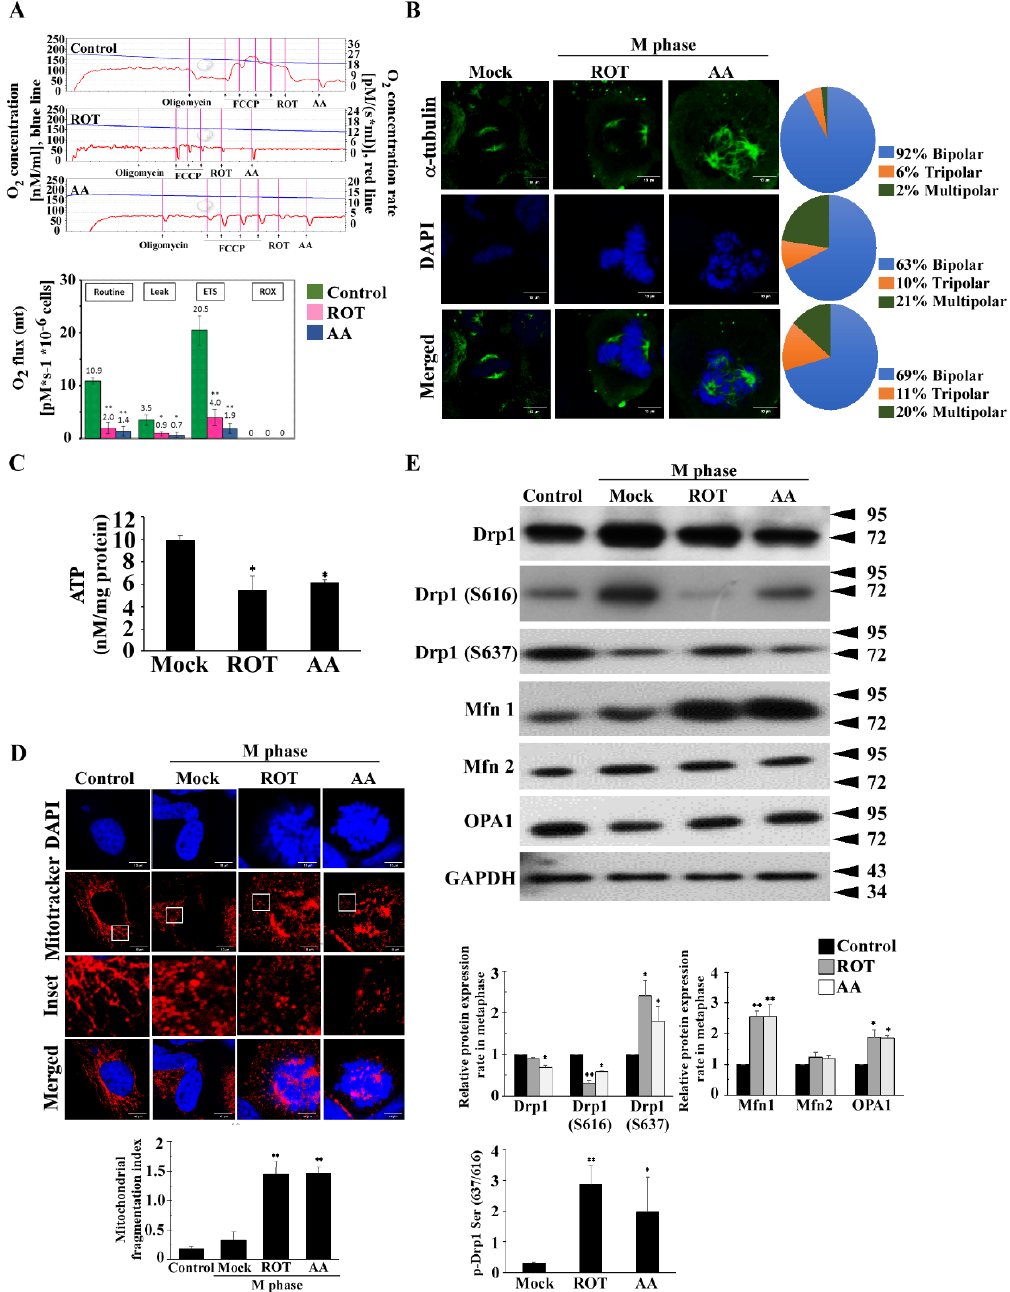
Figure 1. Inhibition of mitochondrial ETC complexes I and III induces multiple spindles formation. ( A ) HeLa cells lost almost all respiratory capacity after ROT or AA treatment. The OCR was determined in the presence of ROT (200 nM), AA (10 μM) and control at 24 h using an oxygen electrode (Ouroboros O2k). The PCP protocol (phosphorylation control protocol) was applied to evaluate OCR, routine, leak, ETS (maximum electron transfer system) and ROX (residual oxygen consumption) values in ROT (pink) or AA (blue) treated HeLa cells compared to control (green) HeLa cells using O 2 k. ( B ) HeLa cells were synchronized at G2/M by nocodazole. More than 300 cells were calculated. Quantitation pie charts indicate the percentage of bipolar, tripolar, and multipolar mitotic cells. ( C ) Normalized ATP measurements in HeLa cells. ( D ) Mitochondrial morphological features in the presence of ROT or AA were evaluated by the changes in mitochondrial dynamics. The mitochondria were stained with MitoTracker Red to evaluate mitochondrial morphology. Blue DAPI represents chromosome. ( E ) HeLa cells were analyzed for mitochondrial dynamics-associated proteins by treating with ROT and AA for 24 h synchronized with nocodazole and then released into the M phase. GAPDH was used as an internal control. The bar graph represents the mean of triplicates ± SD. * p < 0.05, ** p < 0.01 compared with the Mock